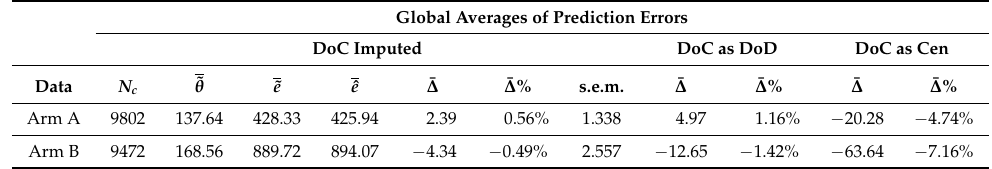
Table 5. Overall results from 10,000 simulations.